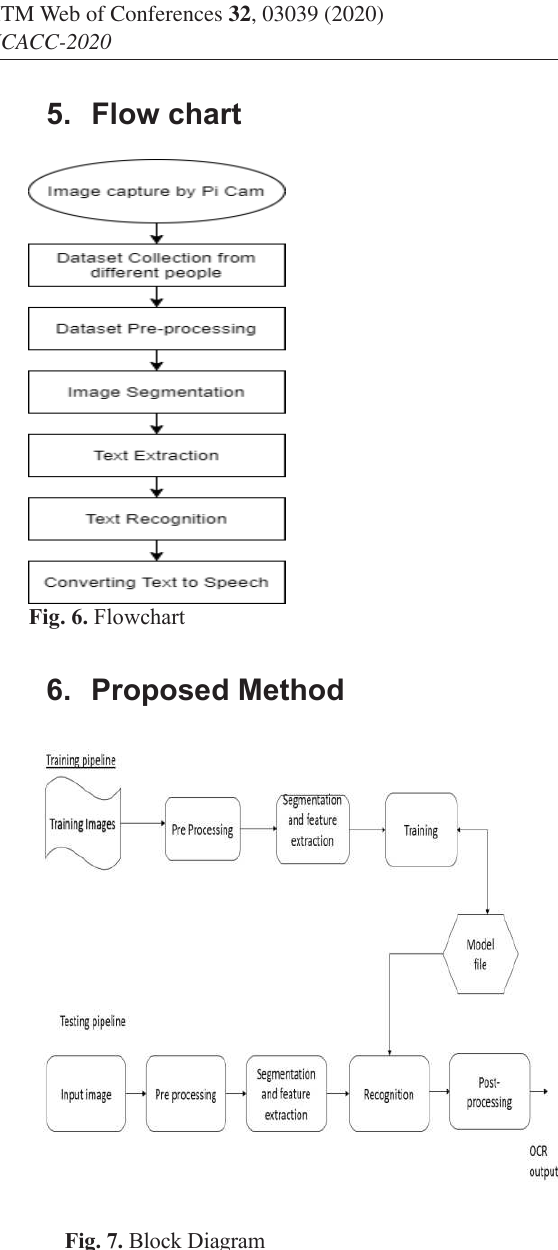
Fig. 7. Block Diagram